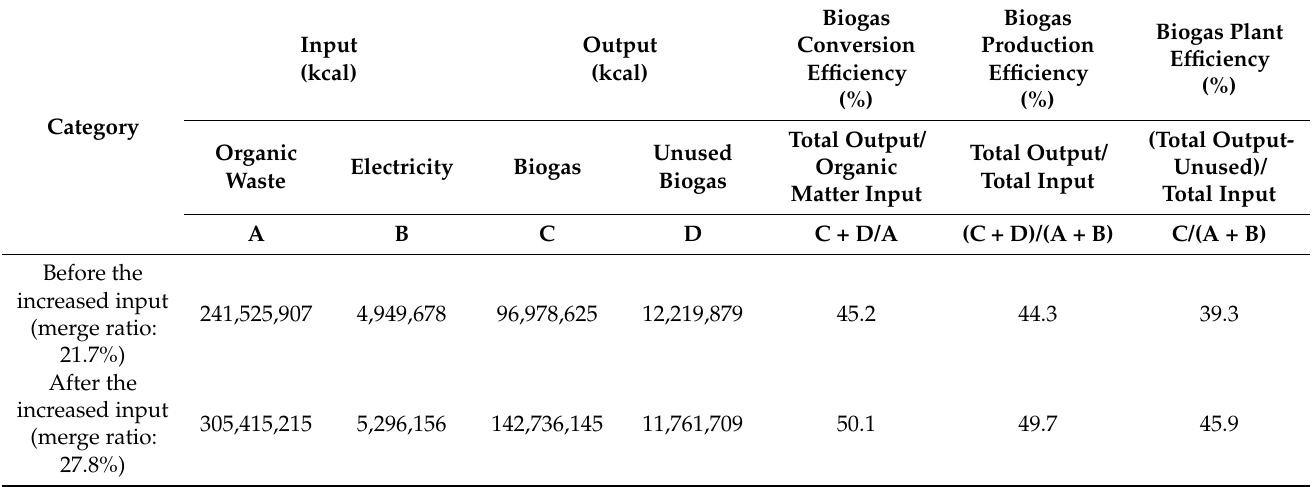
Table 7. Energy balance for biogas energy